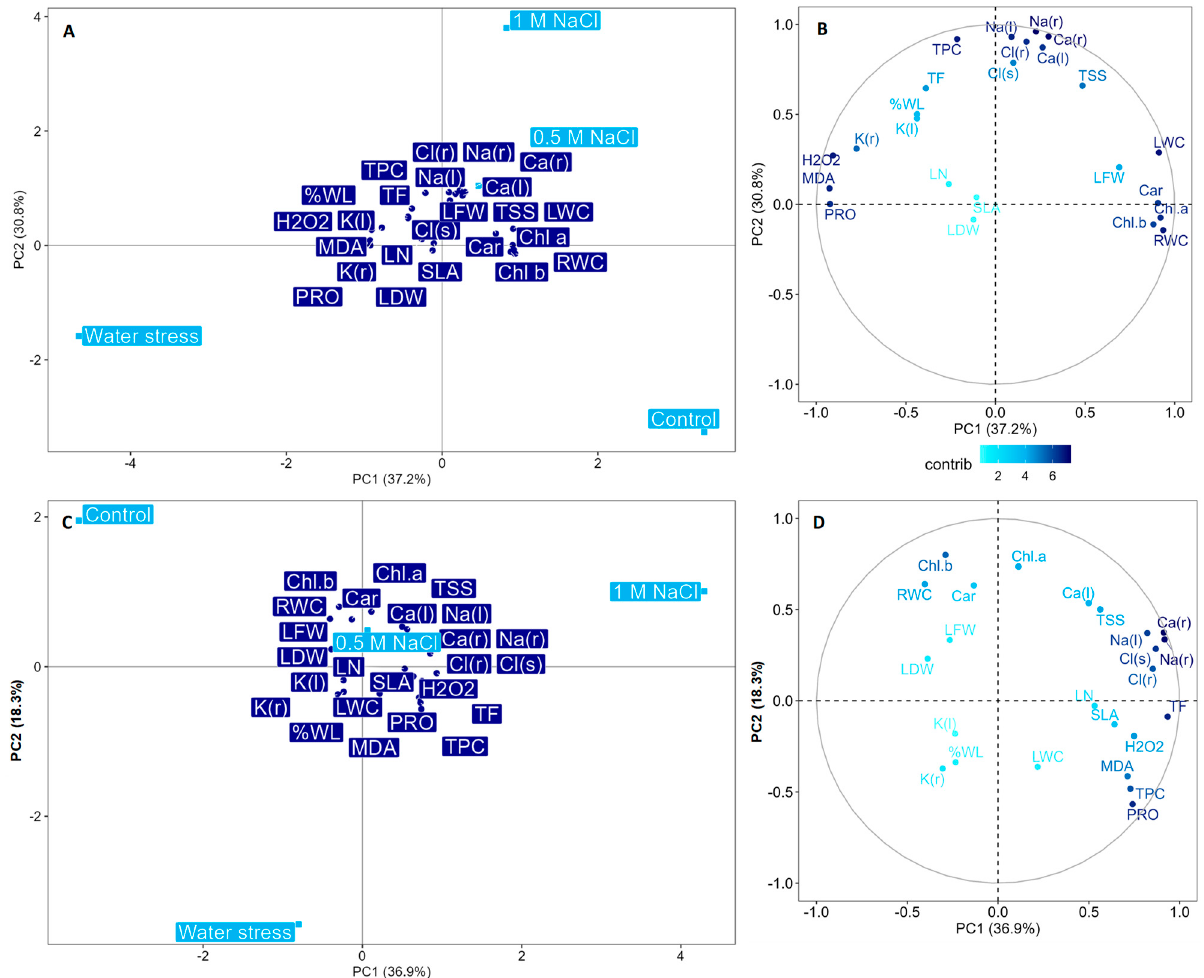
Figure 8. PCA biplot of variables ( A ) following the first stress phase (PCAstress1) and ( C ) the second stress phase (PCAstress2). Light blue squares indicate the barycentres of the four tested treatments (Control, 0.5 M NaCl, 0.1 M NaCl, and Water stress), while dark blue circles indicate the barycentres of the quantitative variables, i.e., the main measured variables, total leaf number (LN), wilted leaf percentage (%WL), specific leaf area (SLA), leaf fresh weight (LFW), leaf dry weight (LDW), leaf water content (LWC), root water content (RWC), chlorophyll a (Chl a), chlorophyll b (Chl b), carotenoids (Car), root sodium concentration (Na(r), leaf sodium concentration (Na(l)), root chloride concentration (Cl(r)), leaf chloride concentration (Cl(l)), root potassium concentration (K(r)), leaf potassium concentration (K(l)), root calcium concentration (Ca(r)), leaf calcium concentration (Ca(l)), proline (PRO), total soluble sugars (TSS), malondialdehyde (MDA), hydrogen peroxide (H 2 O 2 ), total phenolic compounds (TPC), and total flavonoids (TF). Correlation circle plot of the main measured traits ( B ) following the first stress phase (PCAstress1) and ( D ) the second stress phase (PCAstress2). The growing colour tone of the dots, from light blue to dark blue, indicates the increasing contribution of a variable to the definition of the first two principal components.